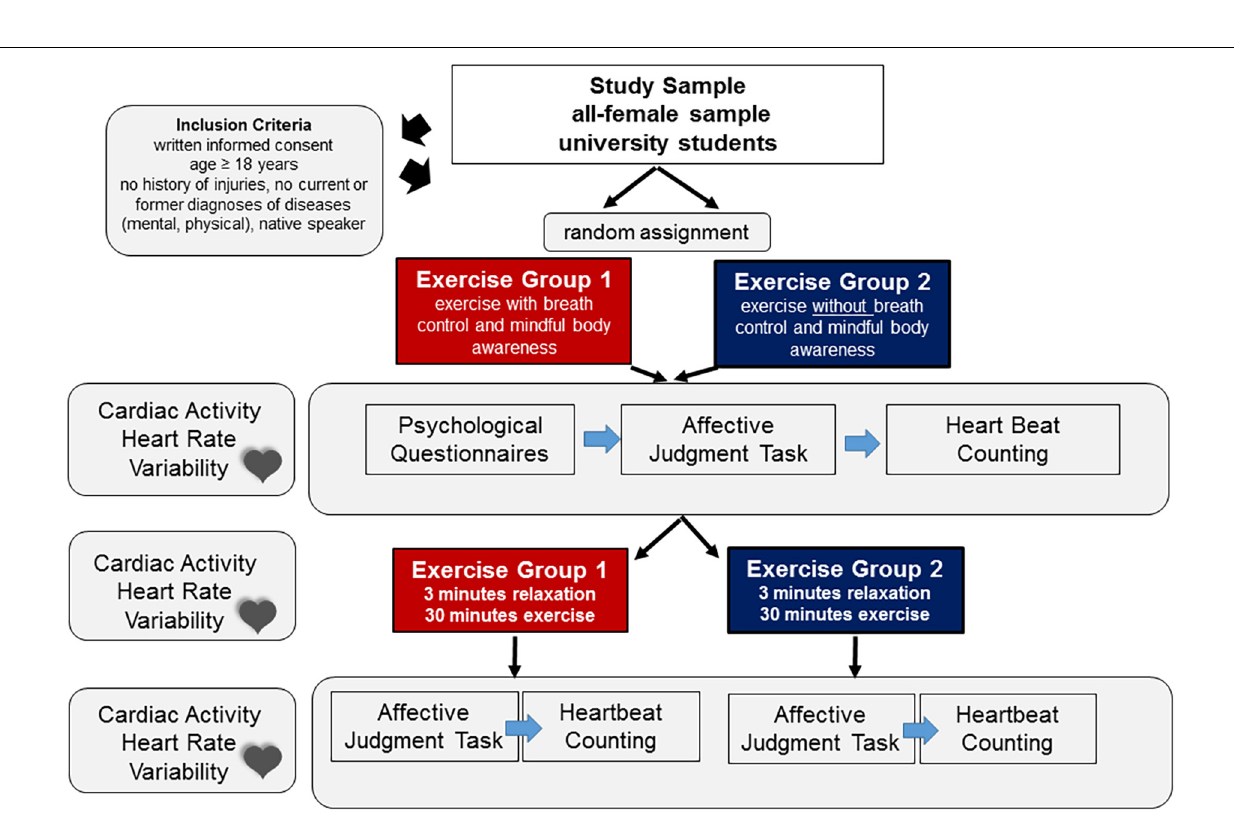
FIGURE 2 | Overview of the study